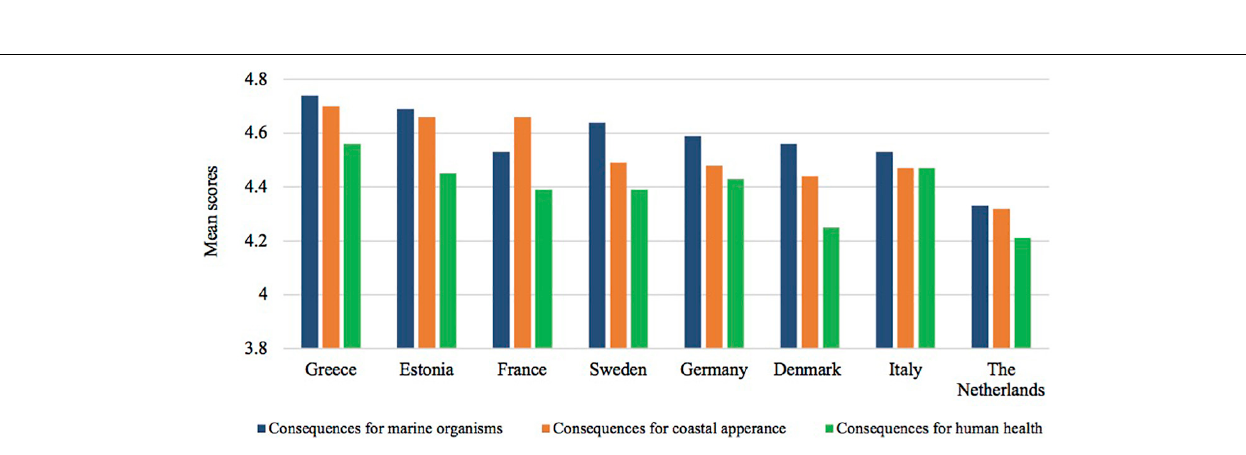
FIGURE 6 | Mean scores of perceived negative impacts of marine litter on biodiversity, human health and coastal appearance by country of residence. Response options range from 1 = totally disagree to 5 = totally agree to the following statements: “ Marine plastic severely harms marine organisms ”; “ Marine plastic reduces the beauty or coasts and seas ”; “ Microplastic is a potential health risk for humans